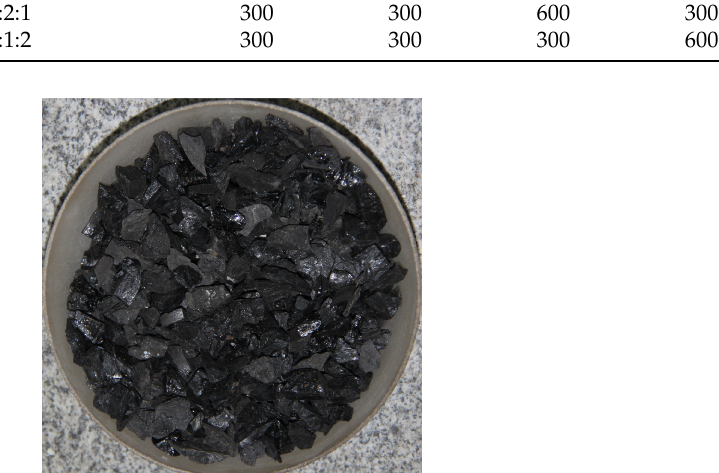
Figure 5. Grain size (10–15 mm) of non-cemented coal separated by the sieving machine.